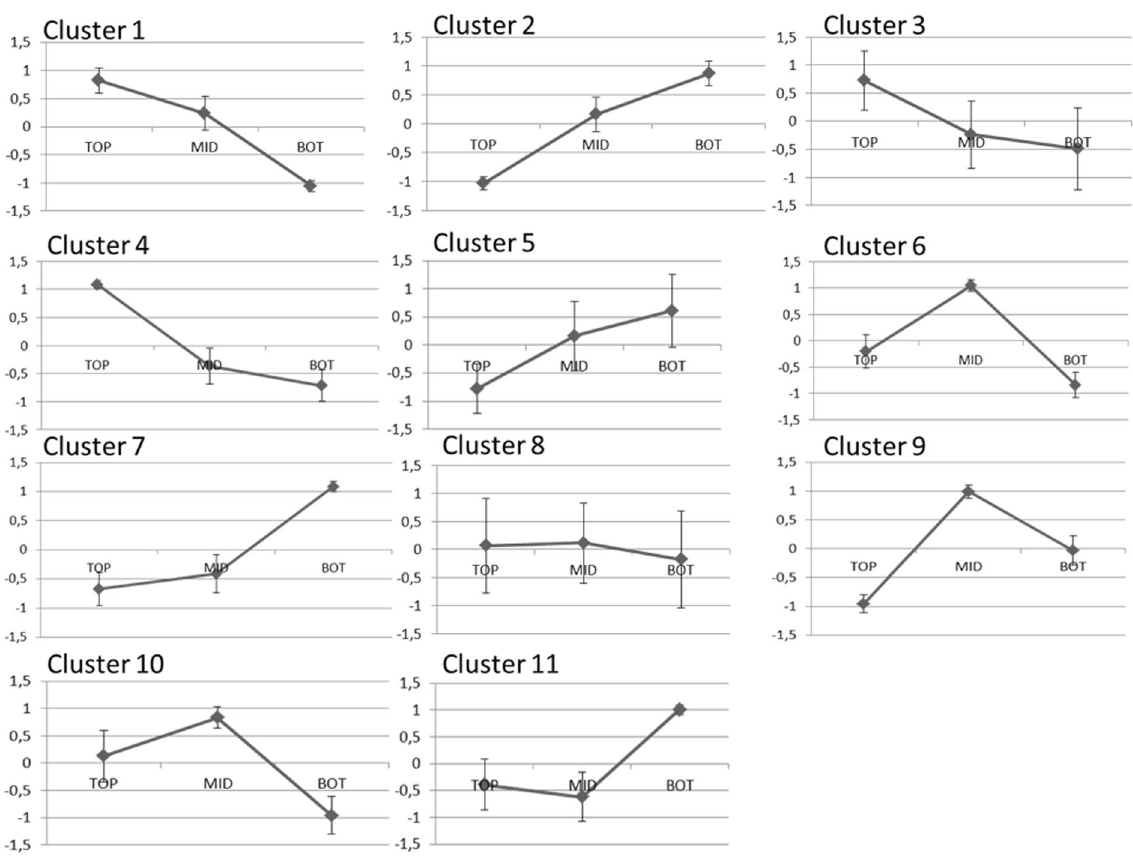
Figure 2. Profiles of the eleven clusters of genes obtained using a Pearson coefficient threshold of 0.75. The data represent the log 2 RPKM rescaled values ± standard deviation (the rescaled values were calculated by subtracting to each contig expression value the average among the three stem regions and dividing by the standard